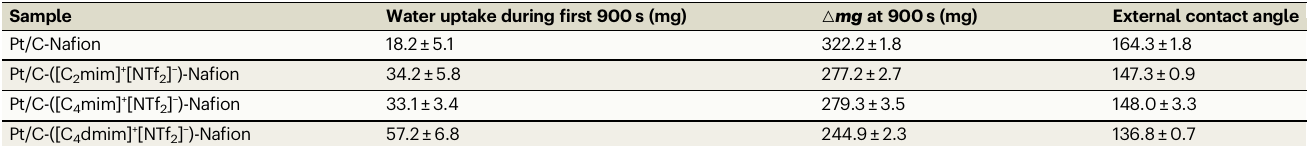
Table 1 | Water uptake and external contact angle catalyst layers containing various ILs with IL/C ratio of 1.28 measured by Krüss tensiometer